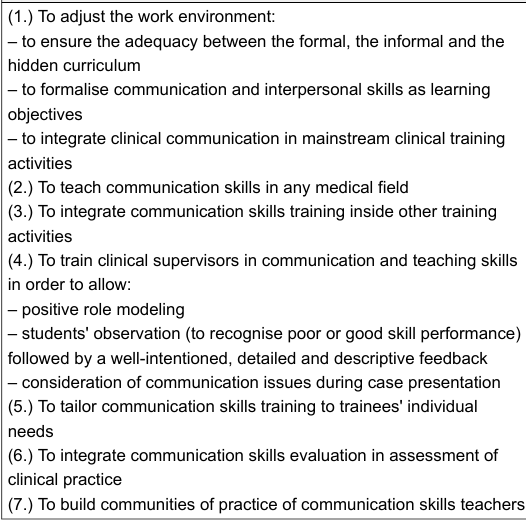
Table 2 : Strategies to improve communication skills training in clinical practice.